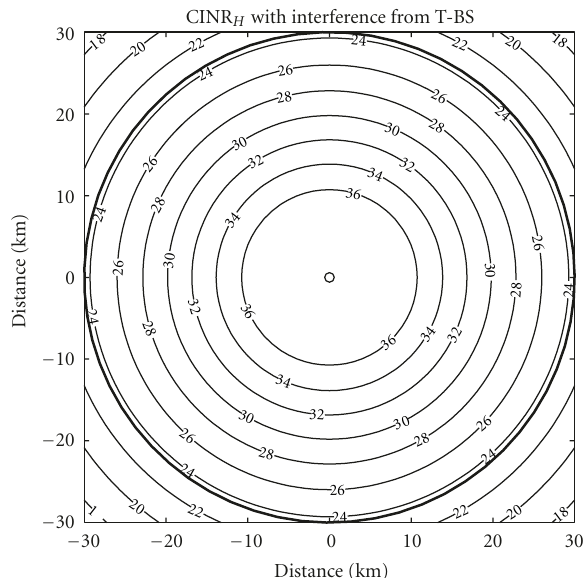
Figure 4: CINR T performance contour plot of T-BS (marked as “x”) coverage area.